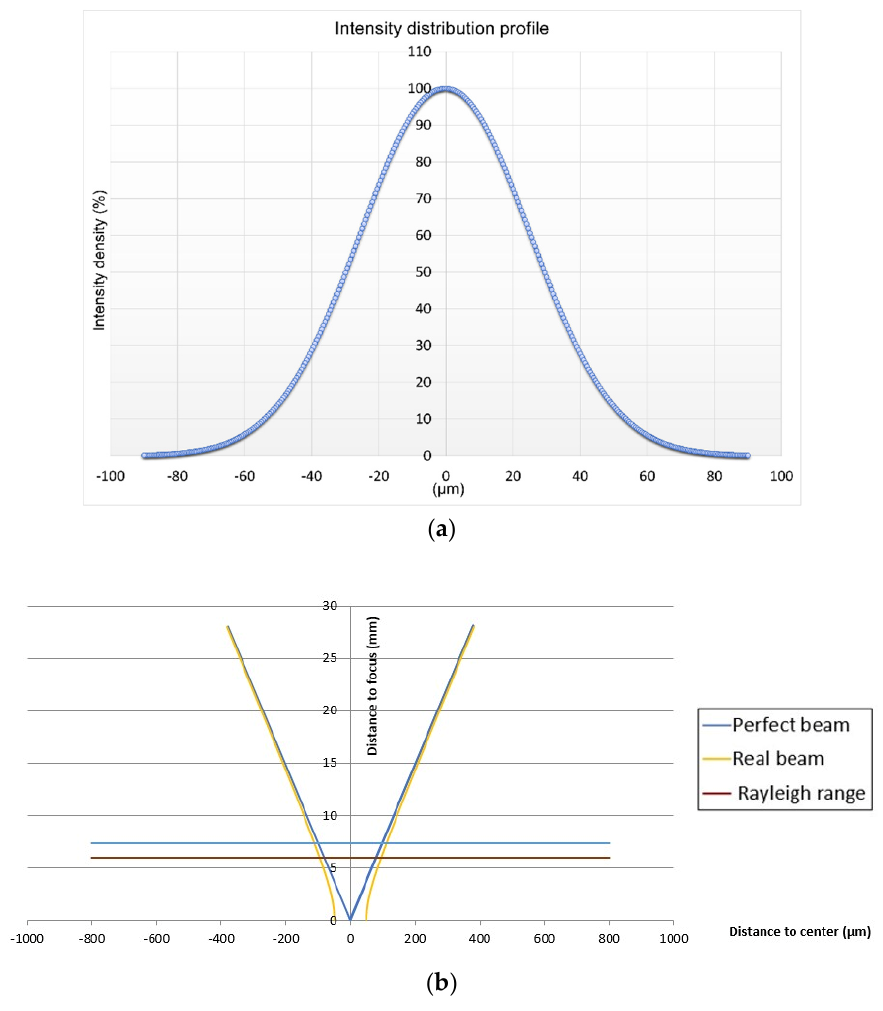
Figure 1. Intensity distribution profile of laser beam ( a ) and beam simulation ( b ) of TruMark 5020 laser equipment.